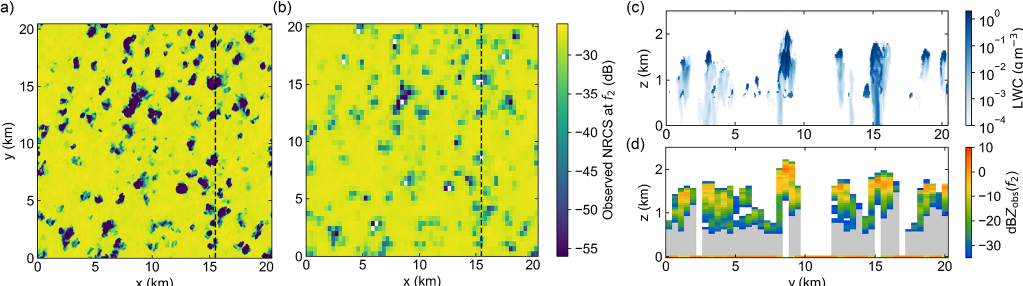
Figure 4. Selected results from RICO forward simulations. Simulated observed ocean surface NRCS at 174.8GHz before (a) and after (b) filtering for instrument horizontal resolution and detection sensitivity. (c) LWC profiles for the along-track transect indicated by the dashed line in panels (a) and (b) . (d) Corresponding observed reflectivity profiles at 174.8GHz. Positions where cloud-to-surface partial-column water vapor retrievals can be performed are highlighted with gray shading.